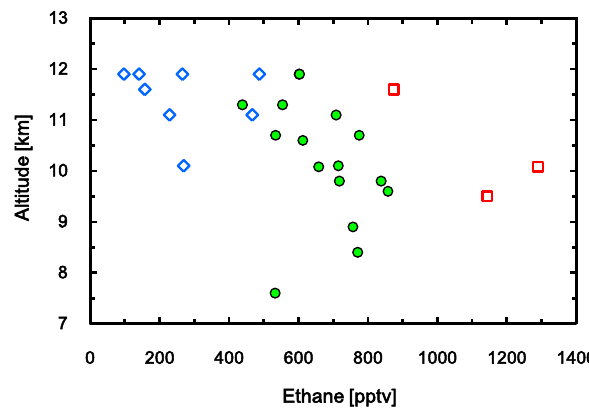
Fig. 5. Relationship between ethane mixing ratios and altitude during return flights between Frankfurt, Guangzhou and Manila in February 2008. Tropospheric samples are represented by filled circles, open squares represent samples with backward trajectories originating in North America and open diamonds represent samples with stratospheric